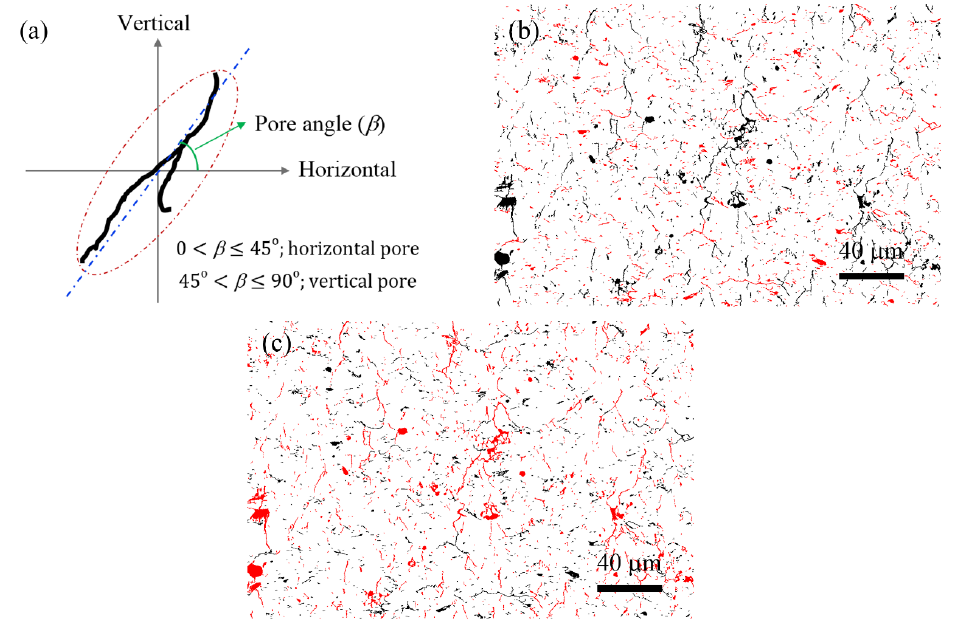
Figure 3. Schematic diagrams of methods to classify pores by ( a ) orientation feature: the effect of dividing pores into ( b ) horizontal and ( c ) vertical pores.